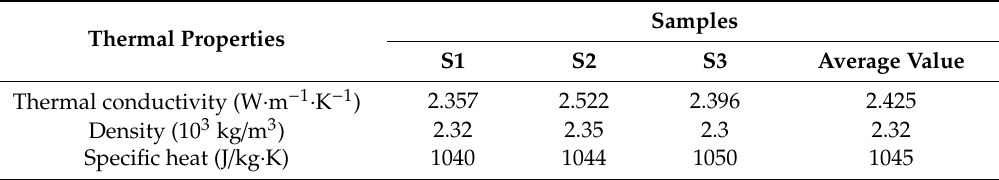
Table 2. Ground properties from the laboratory test.